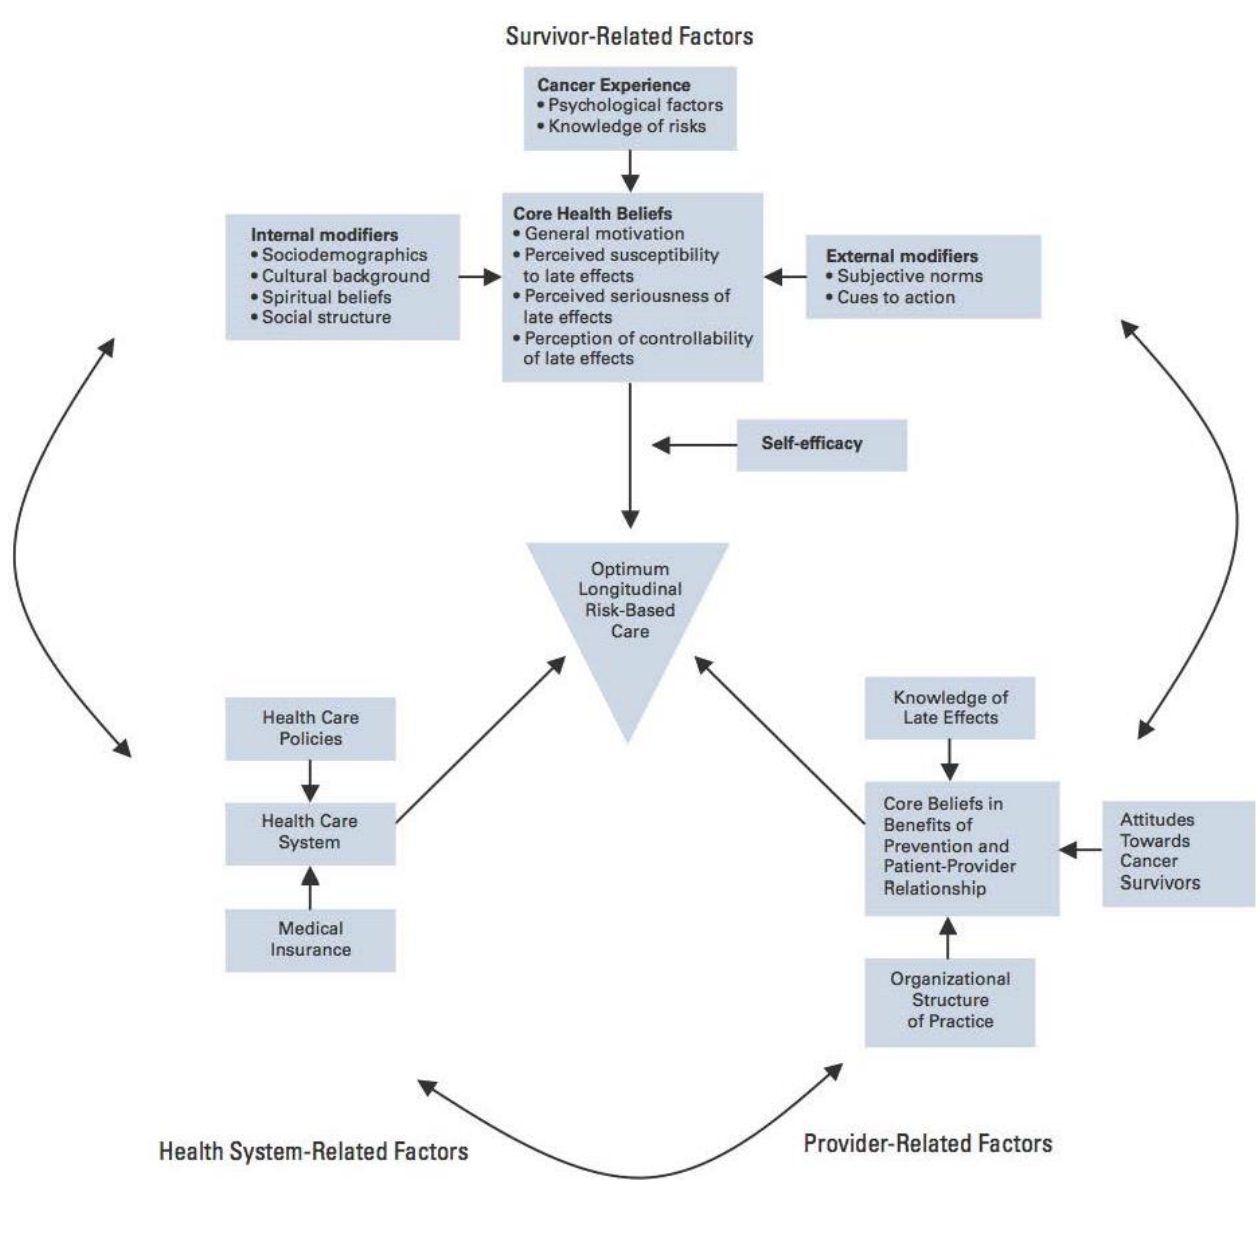
Figure 3. Theoretical model of potential barriers and enablers to the longitudinal cancer-related health care of adult survivors of childhood cancer. Reprinted with permission from Oeffinger, K.C.